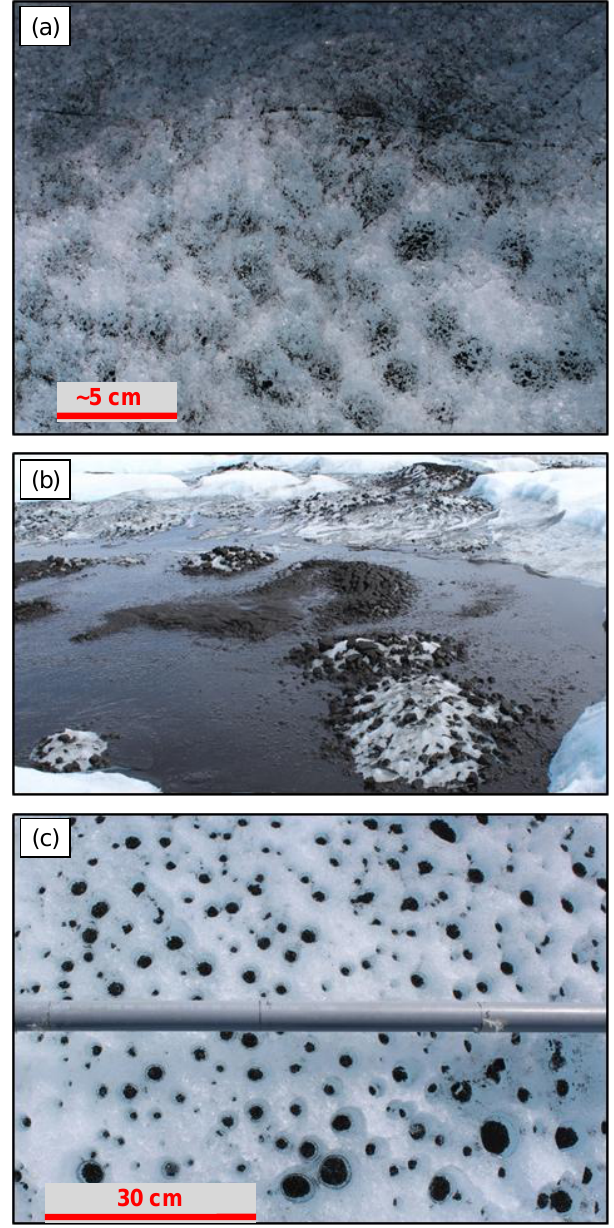
Figure 1. Debris on the ice sheet surface at approximately 67.0 ◦ N, 49.3 ◦ W, 1030m, in the 2012 melt season. (a) Dispersed debris. The foreground shows debris released by the melting-out of cryoconite holes while the more uniform cover in the background is typical “dirty ice”. The linear feature oriented right to left is a healed frac- ture. The image width at the surface is ∼ 50cm. (b) Thick deposits in a slowly draining lake bed, here reaching ∼ 6cm thick. (c) Cry- oconite holes. The plastic pole is marked at 30cm intervals. These are relatively small cryoconite holes; some reach over 1m in diam-